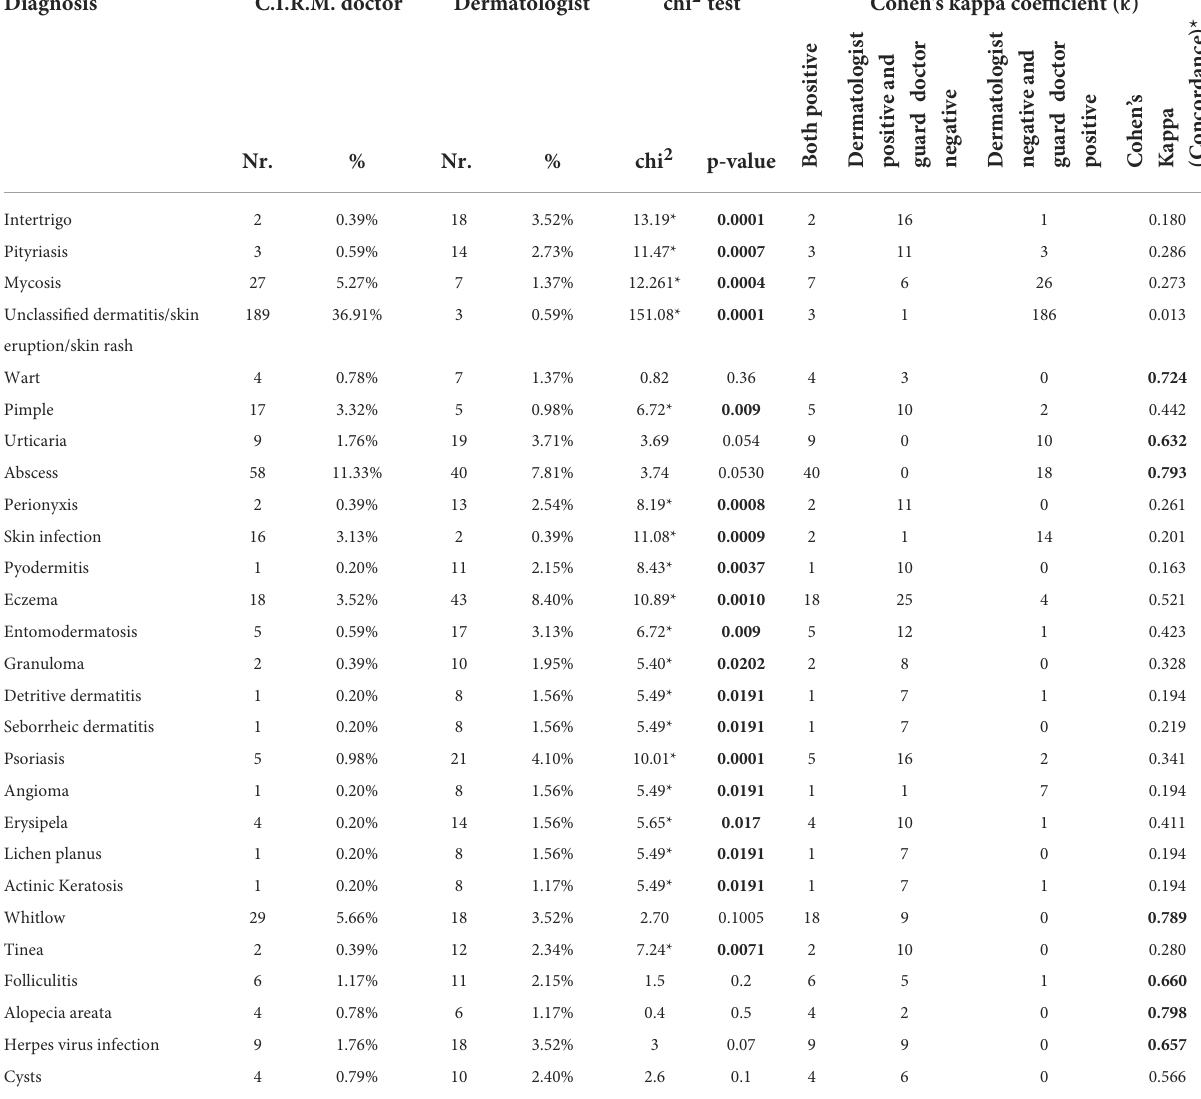
TABLE 1 Comparison between C.I.R.M. doctors’ and dermatologist’s diagnoses, chi 2 test ( p > 0.05) and Cohen’s K-coefficient ( < 0.01: null; 0.01–0.2 low; 0.21–0.4 modest; 0.41–0.6 moderate; 0.61–0.8 good; 0.81–1 excellent).